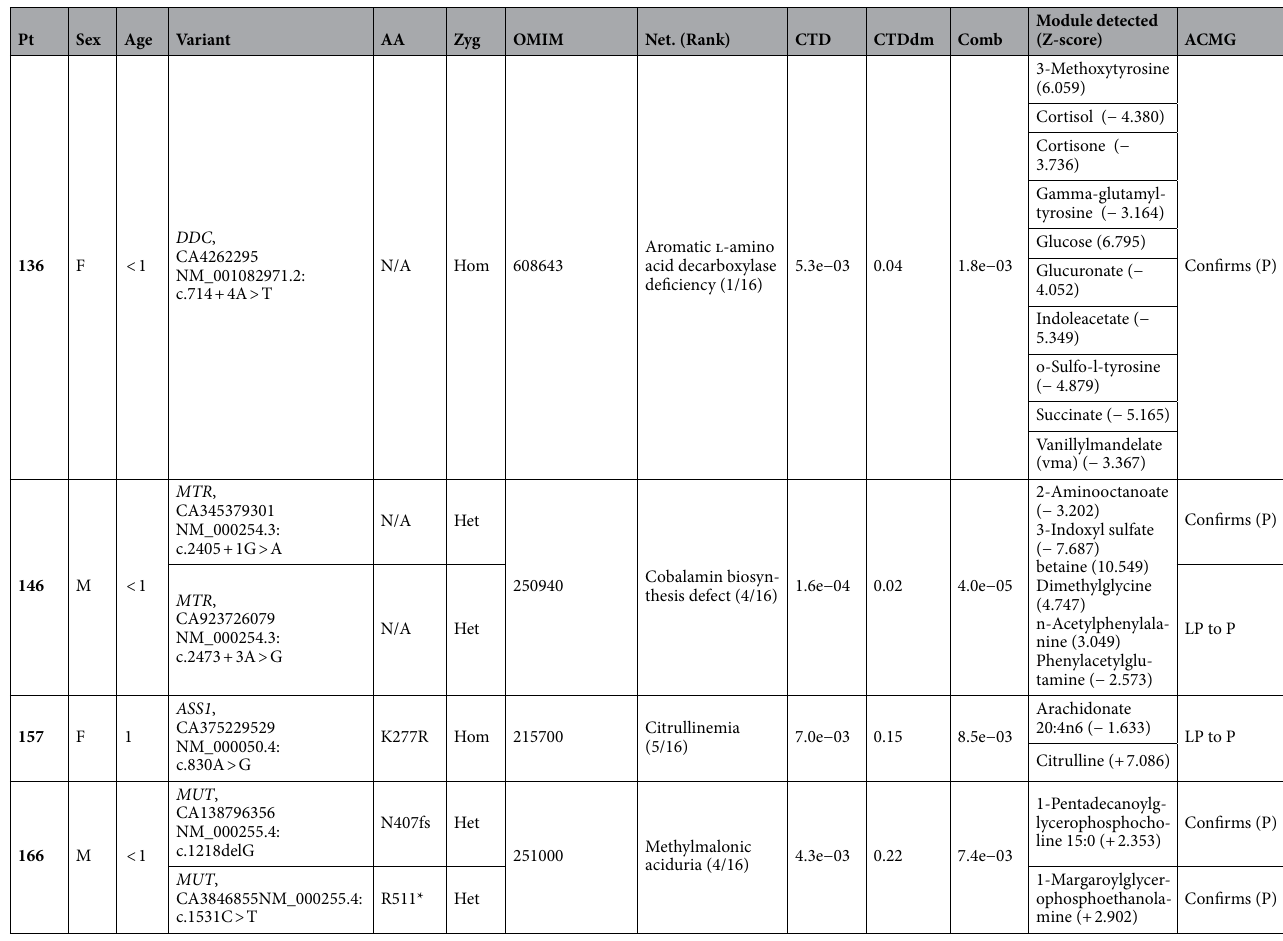
Table 4. Variant re-interpretations based on evidence quantified from the metabolome. 10/10 variant interpretations discovered by manually inspecting metabolomics data from 170 individuals in Alaimo et al. 22 were reproduced using our automated pipeline, where 9/10 of those had strong significance and 1/10 had borderline significance. One novel finding is also reported, where one individual was diagnosed with a PBD, highlighting the ability of CTD-based metrics to detect disease-relevant signatures that are too complex or subtle to detect using manual inspection. Pt patient, AA amino acid change, Zyg zygosity, OMIM diagnosis identifier from the Online Mendelian Inheritance in Man catalog, Net disease-specific network, Comb Brown’s combined p value, ACMG The American College of Medical Genetics variant pathogenicity